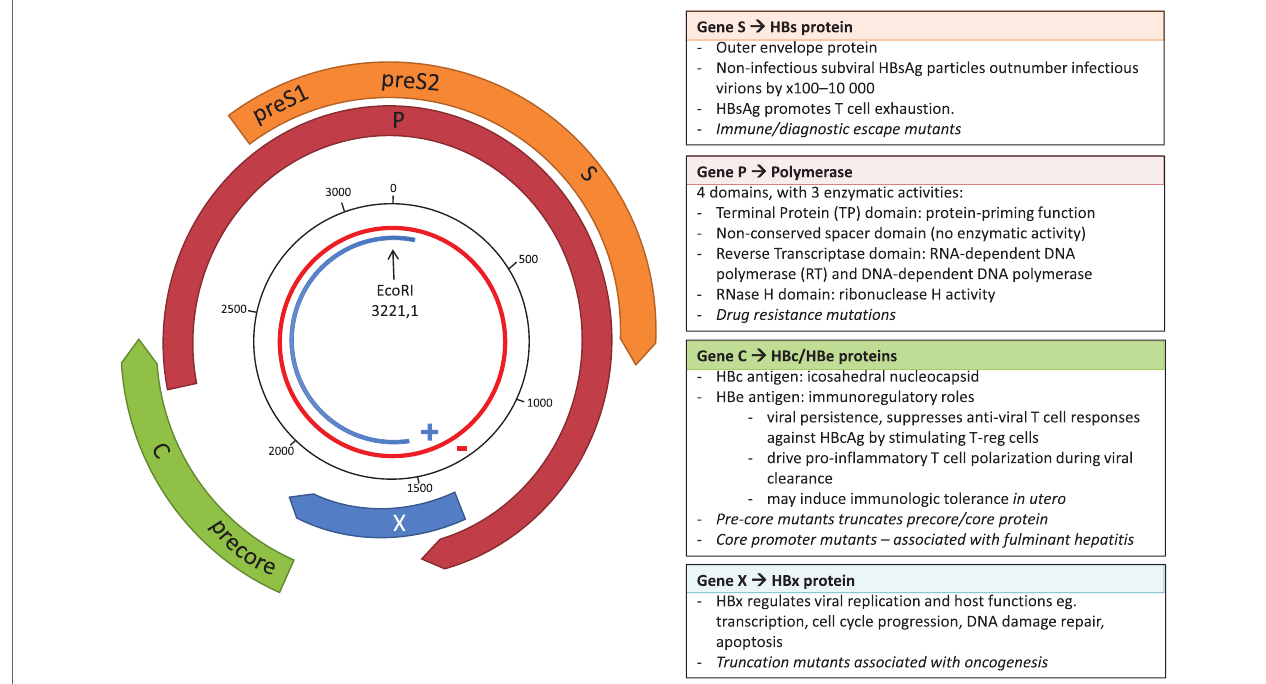
FigURe 1 | The overlapping genome structure of hepatitis B virus (HBV). The partially double-stranded circular DNA genome is shown with the negative strand in red and the positive strand in blue. The black numbered circle indicates the nucleotide position. The four genes, X, Polymerase (P), Core (C), and Surface (S) are represented by the thick colored arrows, with the main functional roles of the four genes shown in the boxes, and key impact of mutations shown in italics.